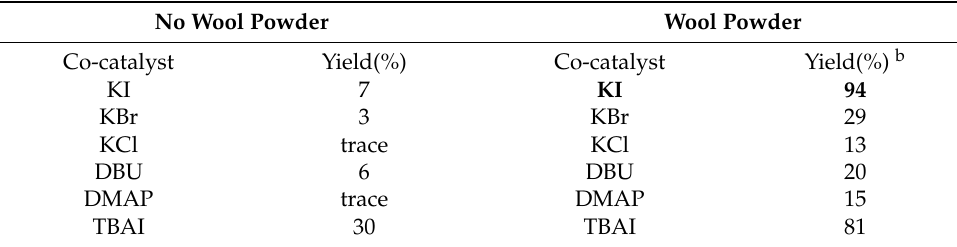
Table 1. Co-catalyst optimization a .